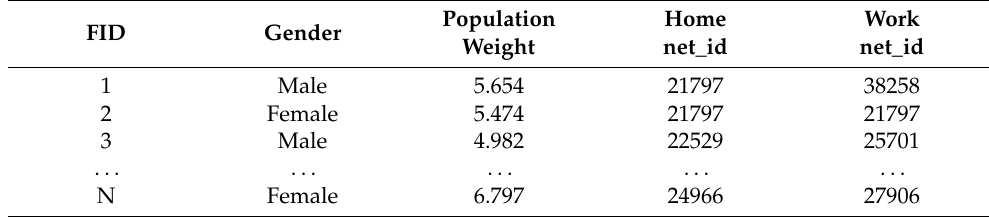
Table 1. Examples of mobile phone location records. FID Gender